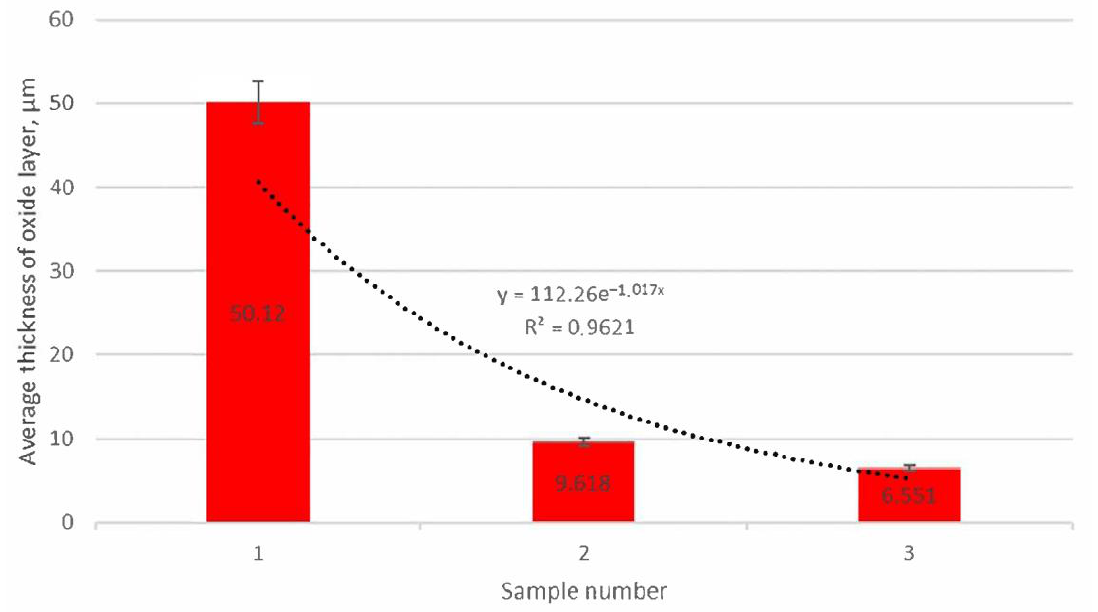
Figure 13. Average thickness of the oxide layer for the samples under analysis.